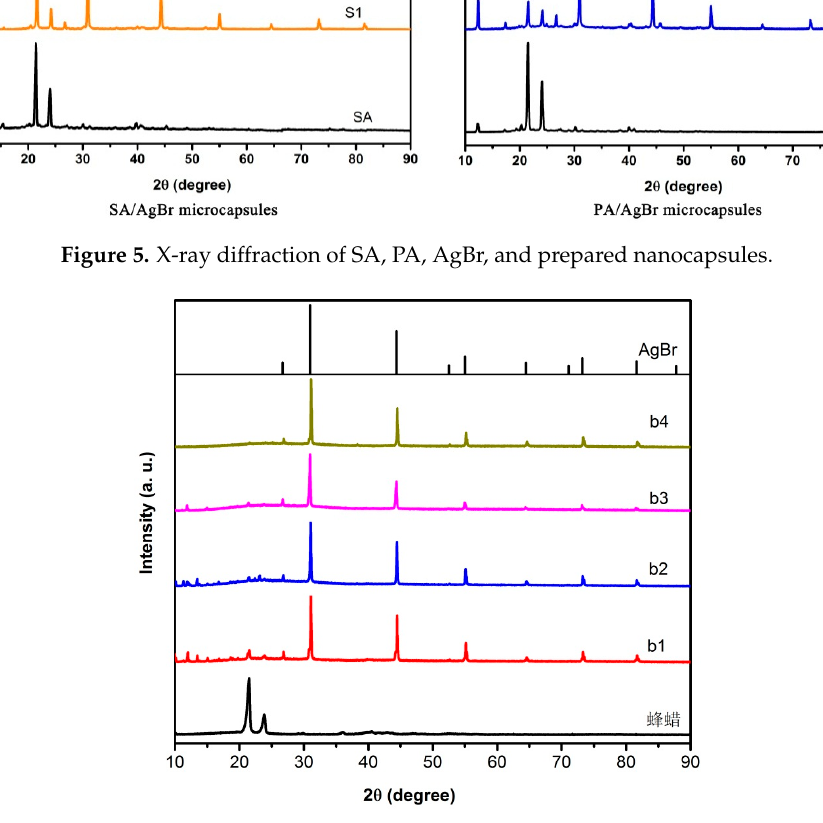
Figure 6. X-ray diffraction of the beeswax/AgBr microcapsules. Energies 2019 , 12 , x FOR PEER 8 of 13 Figure6. X-ray diffraction of the beeswax/AgBr microcapsules.